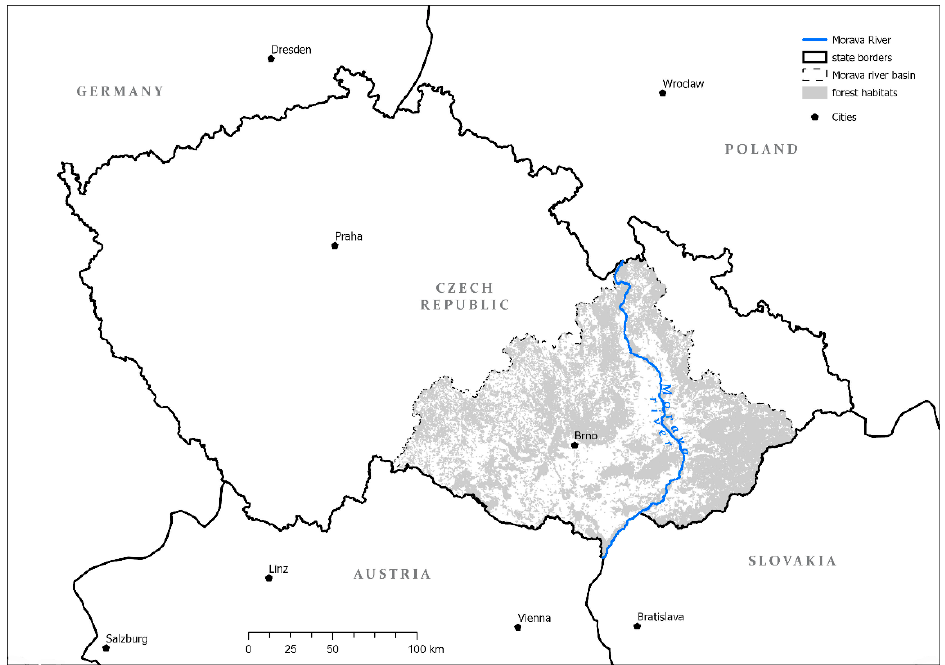
Figure 1. Localization of the study area. The Morava river originates in the Kralicky Sneznik Mountains, near the state border between the Czech Republic and Poland. The length of the Morava river, from its source to the confluence with the Dyje River at the border of the Czech Republic, is about 270 km [20]. The Morava River feeds the Danube river in Slovakia by an average flow of 120 m 3 × s − 1 . The drainage area of the Morava river is 21,132 km 2 . The watershed line running along Moravia’s border from west to north and east is part of the European Watershed. the Carpathians (from west to southeast), and between the Danube basin and the North European Plain. Its core geomorphological features are three wide valleys, namely the Dyje-Svratka Valley, the Upper Morava Valley, and the Lower Morava Valley. The first two form the westernmost part of the Outer Subcarpathia, the last is the northernmost part of the Vienna Basin. The valleys surround the low range of the Central Moravian Carpathians